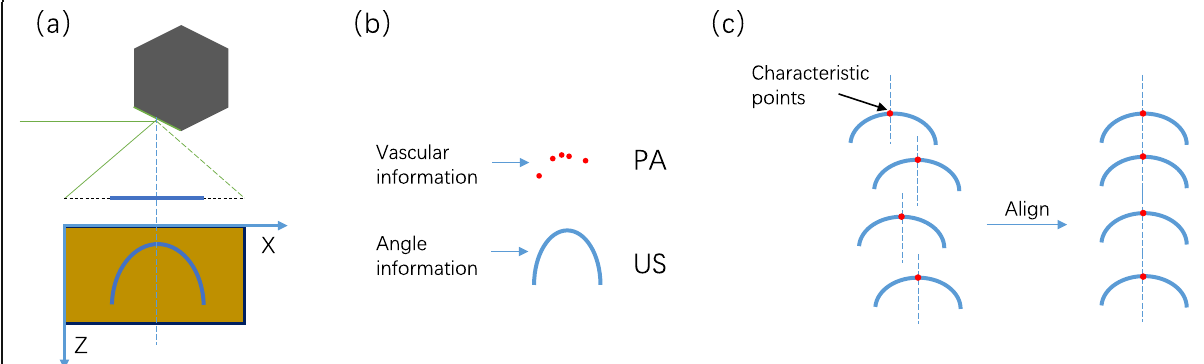
Fig. 5 Method of splicing photoacoustic signals according to the rotation angle information. a Relationship between the angle information for polygon-scanning and B-scan image. b Relationship between the photoacoustic signal and ultrasonic signal in the B-scan image. c Reference alignment of each B-scan using reference points